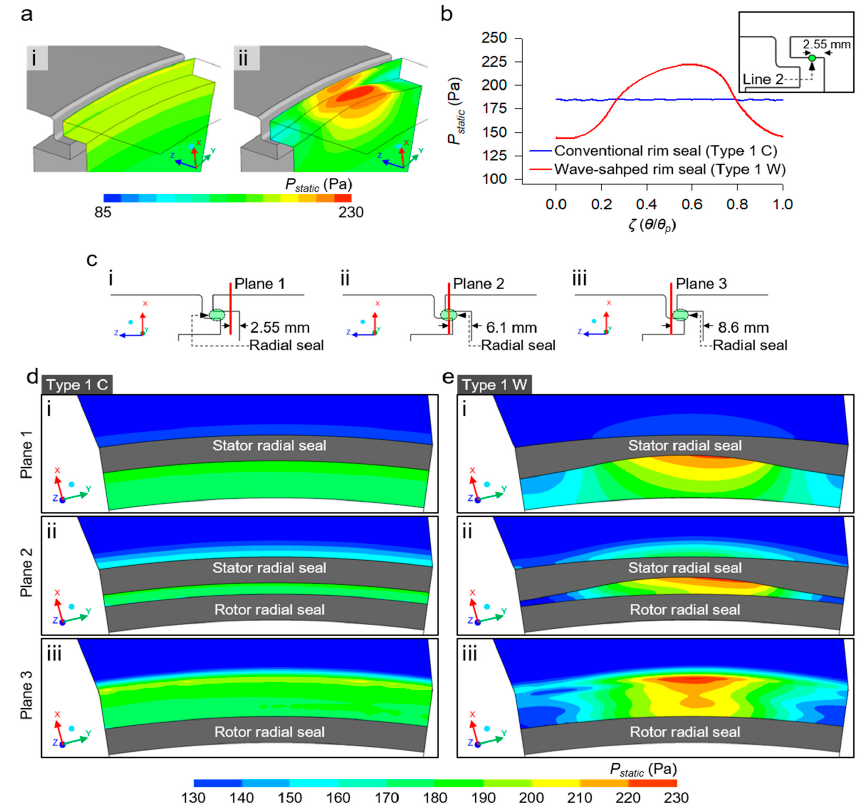
Figure 6. Static pressure distribution near the radius of the Type 1 wheelspace. ( a ) Static pressure contour of stator disk. ( i ) Type 1 C. ( ii ) Type 1 W. ( b ) Static pressure distribution along Line 2 (green point) on the inner surface of the stator radial seal. ( c ) Position of ( i ) Plane 1, ( ii ) Plane 2 and ( iii ) Plane 3. ( d ) Static pressure contour in ( i ) Plane 1, ( ii ) Plane 2, and ( iii ) Plane 3 of Type 1 C. ( e ) Static pressure contour in ( i ) Plane 1, ( ii ) Plane 2, and ( iii ) Plane 3 of Type 1